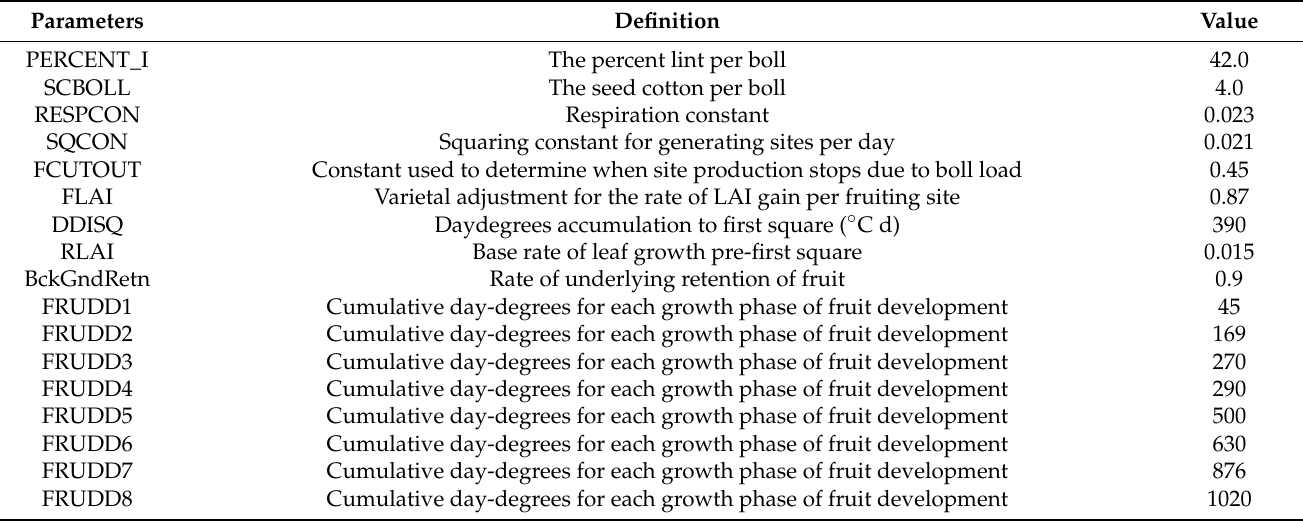
Table 3. The main parameters of the APSIM-OzCot-cotton module used in the